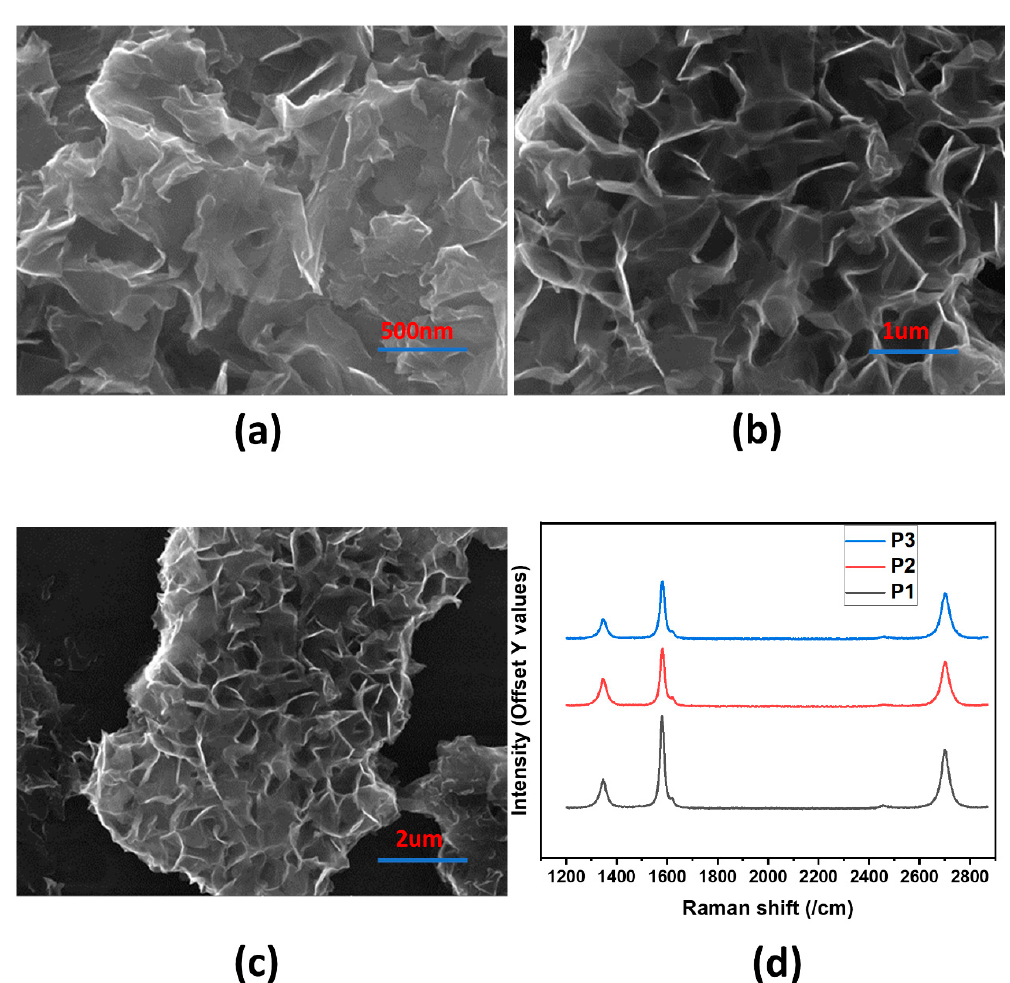
Figure 3. Characterization of graphene flowers, ( a – c ) field emission scanning electron microscope (FESEM) analysis, ( d ) Raman analysis.